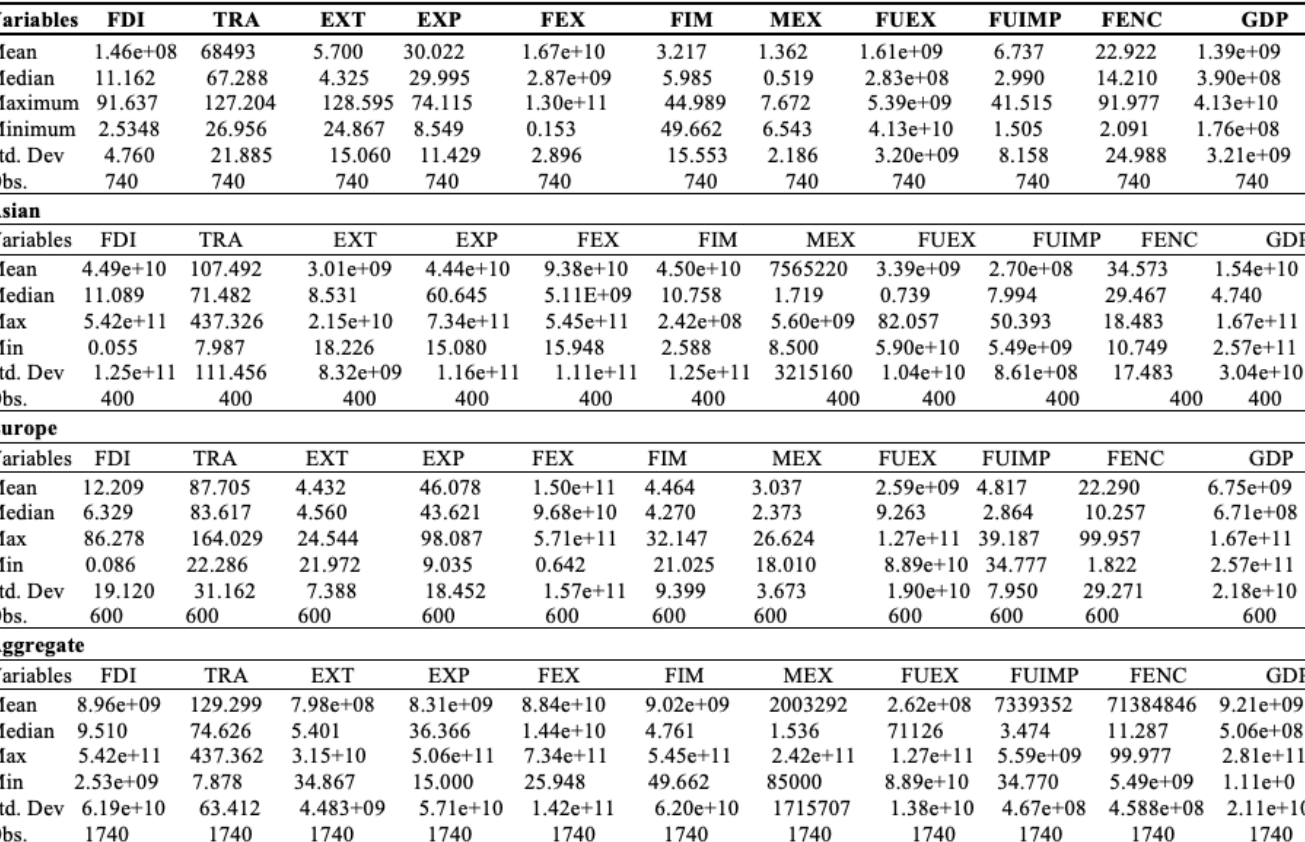
Table 1: Descriptive Statistics